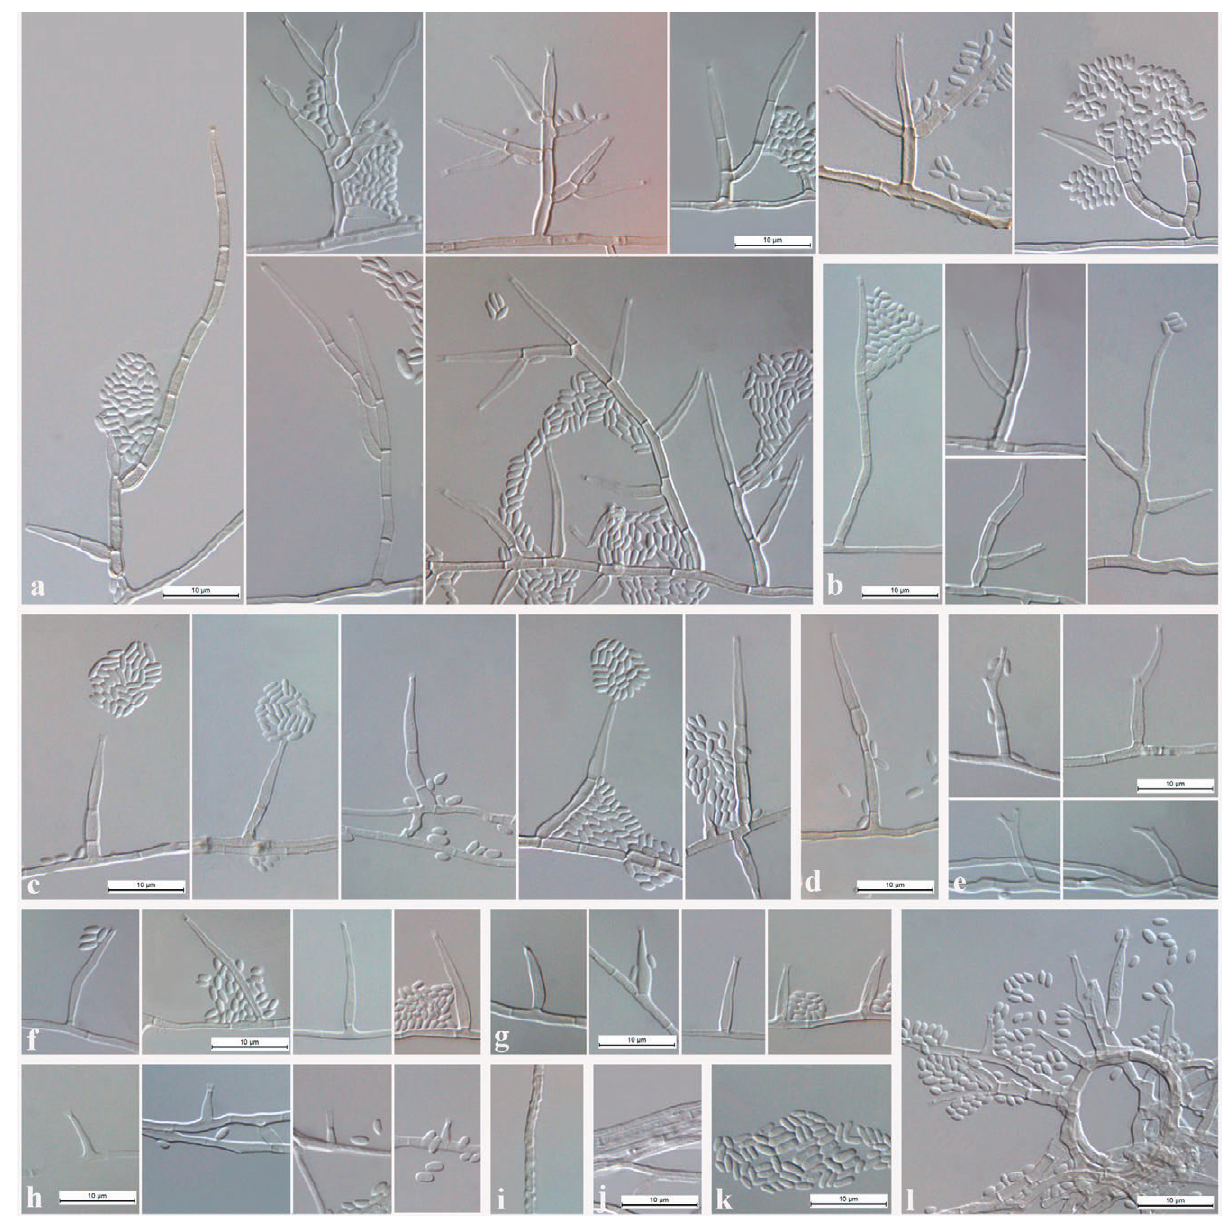
Figure 3. Representative light micrographs (Nomarski differential interference contrast) of Phaeoacremonium italicum . ( a ) Branched conidi- ophores; ( b ) unbranched conidiophores with lateral phialides; ( c ) unbranched septate conidiophores; ( d ) conidiophores showing percurrent rejuvenation; ( e ) polyphialides; ( f ) Type III phialides; ( g ) Type II phialides; ( h ) Type I phialides; ( i ) mycelia, showing prominent exudate droplets observed as warts; ( j ) mycelia occurring in bundles; ( k ) conidia; ( l ) hyphal